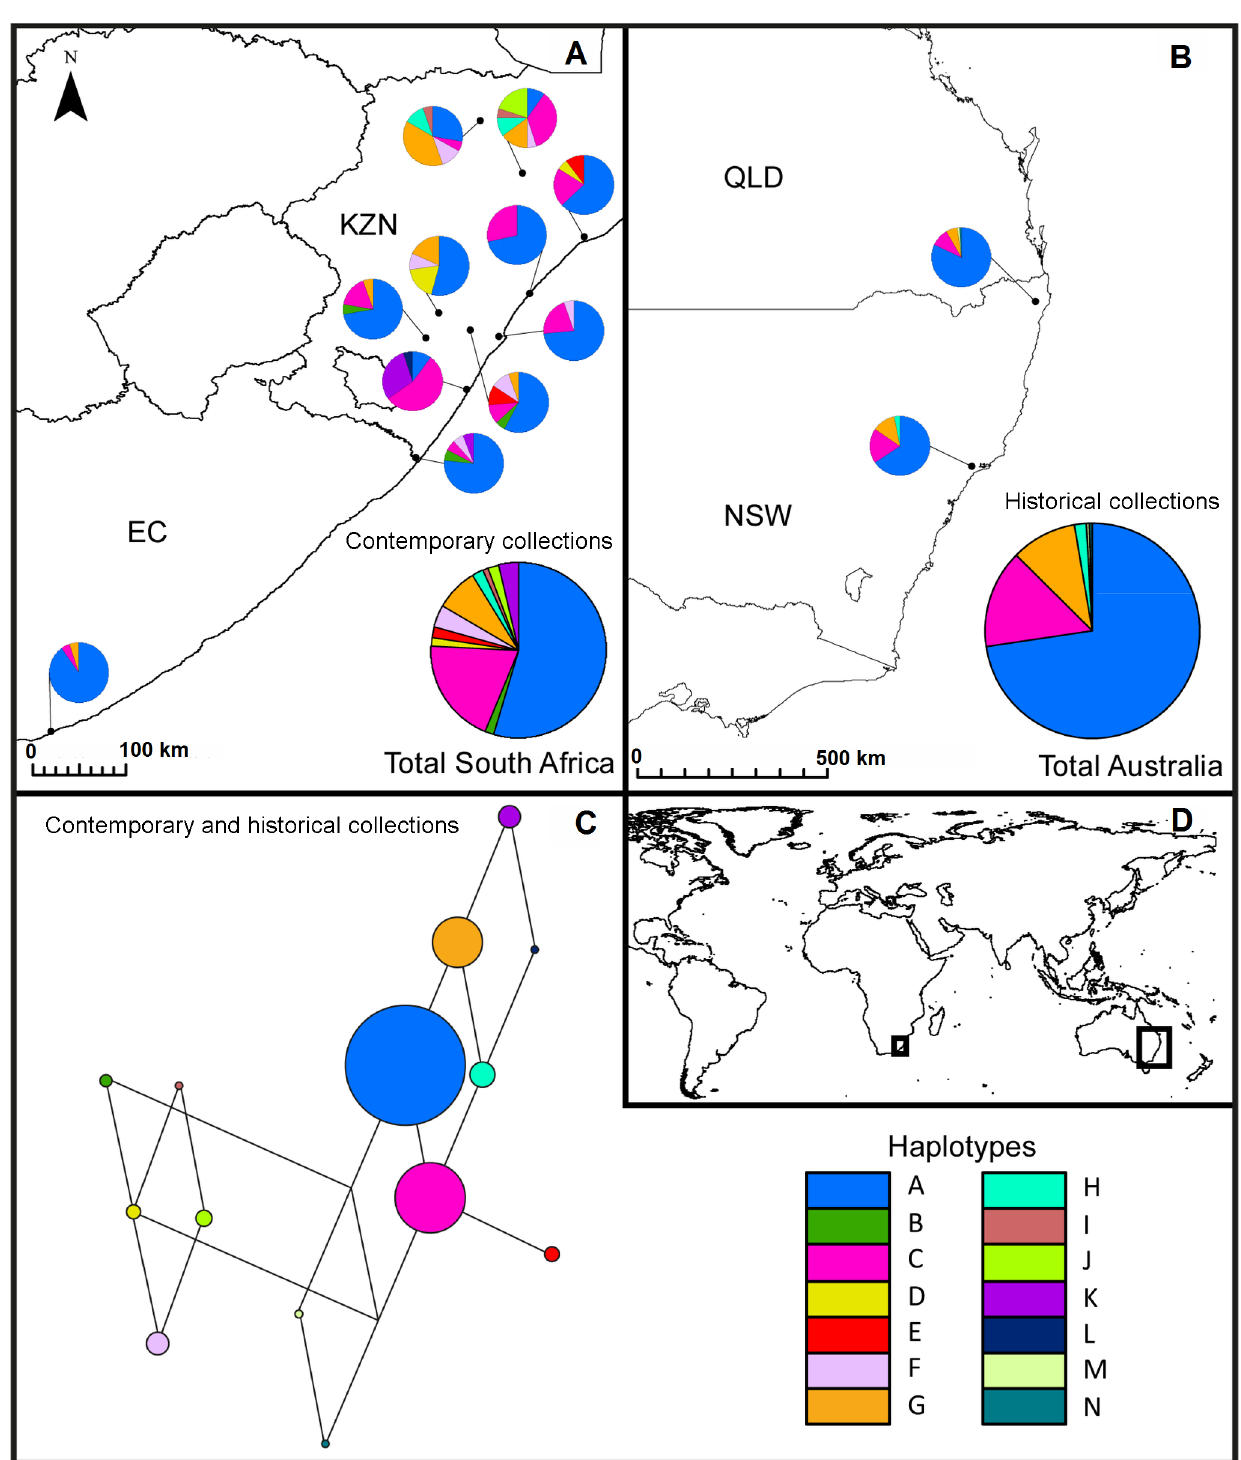
Figure 4. Location of Senecio madagascariensis haplotypes based on three chloroplast microsatellite loci in contemporary samples from South Africa and historical samples from Australia. The proportion of haplotypes found at each sampled site in South Africa (A); haplotypes from all herbarium records in Australia, according to their position in either the south-eastern Australian population P1 or mid-eastern Australian population P2 (B). Size of pie charts are proportional to the number of individuals sampled; median joining network of S. madagascariensis, where the smallest connector length represents one character change (C); map extents (D). Colour codes for haplotypes are consistent throughout.